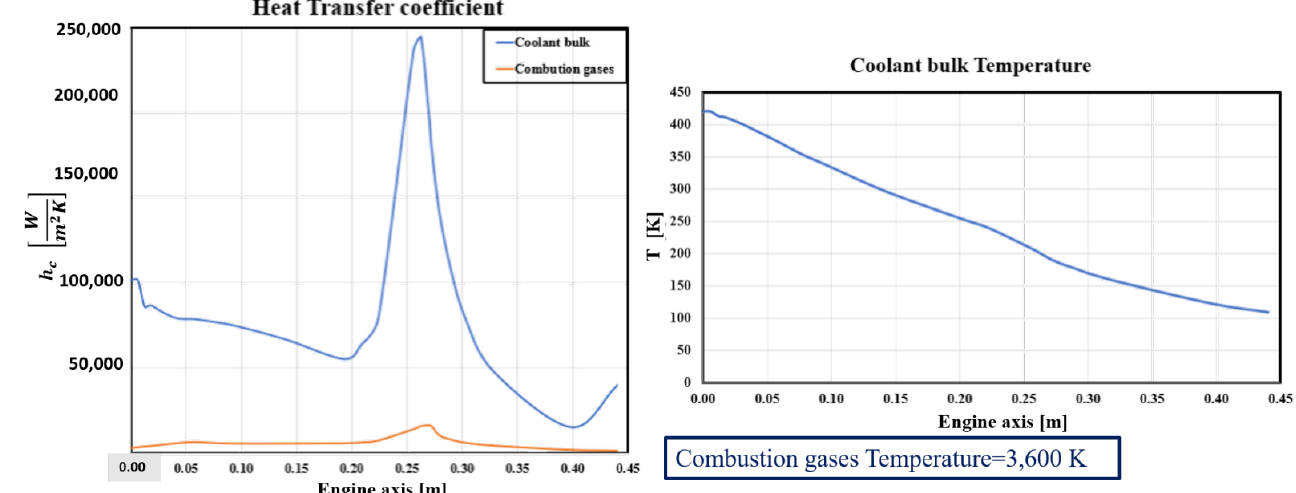
Figure 8. Convective boundary conditions.